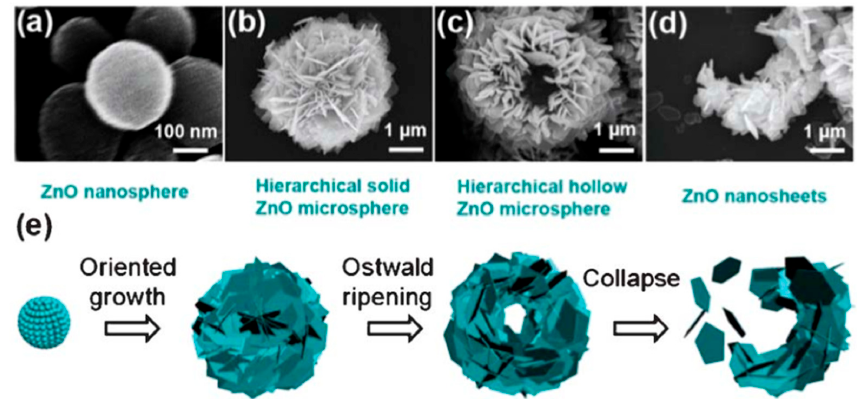
Figure 6. SEM images of the morphology evolution at different reaction times ( a – d ). ( e ) Schematic illustration of the formation process of the hierarchical hollow ZnO structure (Reproduced with permission from [72]. Copyright 2013, Royal Society of Chemistry).